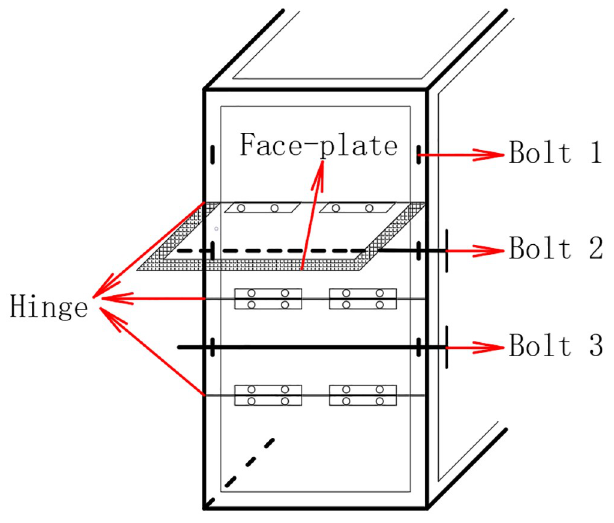
Fig 2. Sketch of the bolt system of a compartment